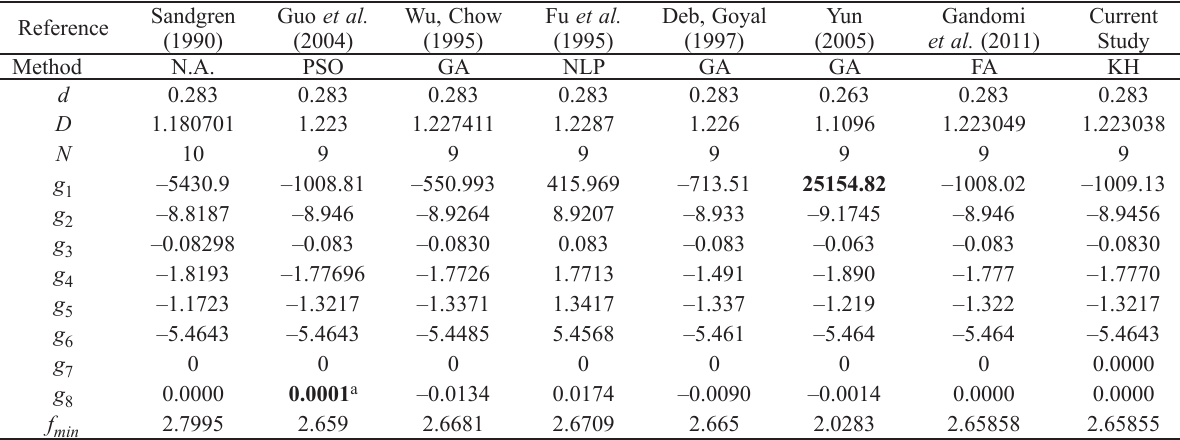
Table 10. Helical spring problem: comparison of KH results with literature